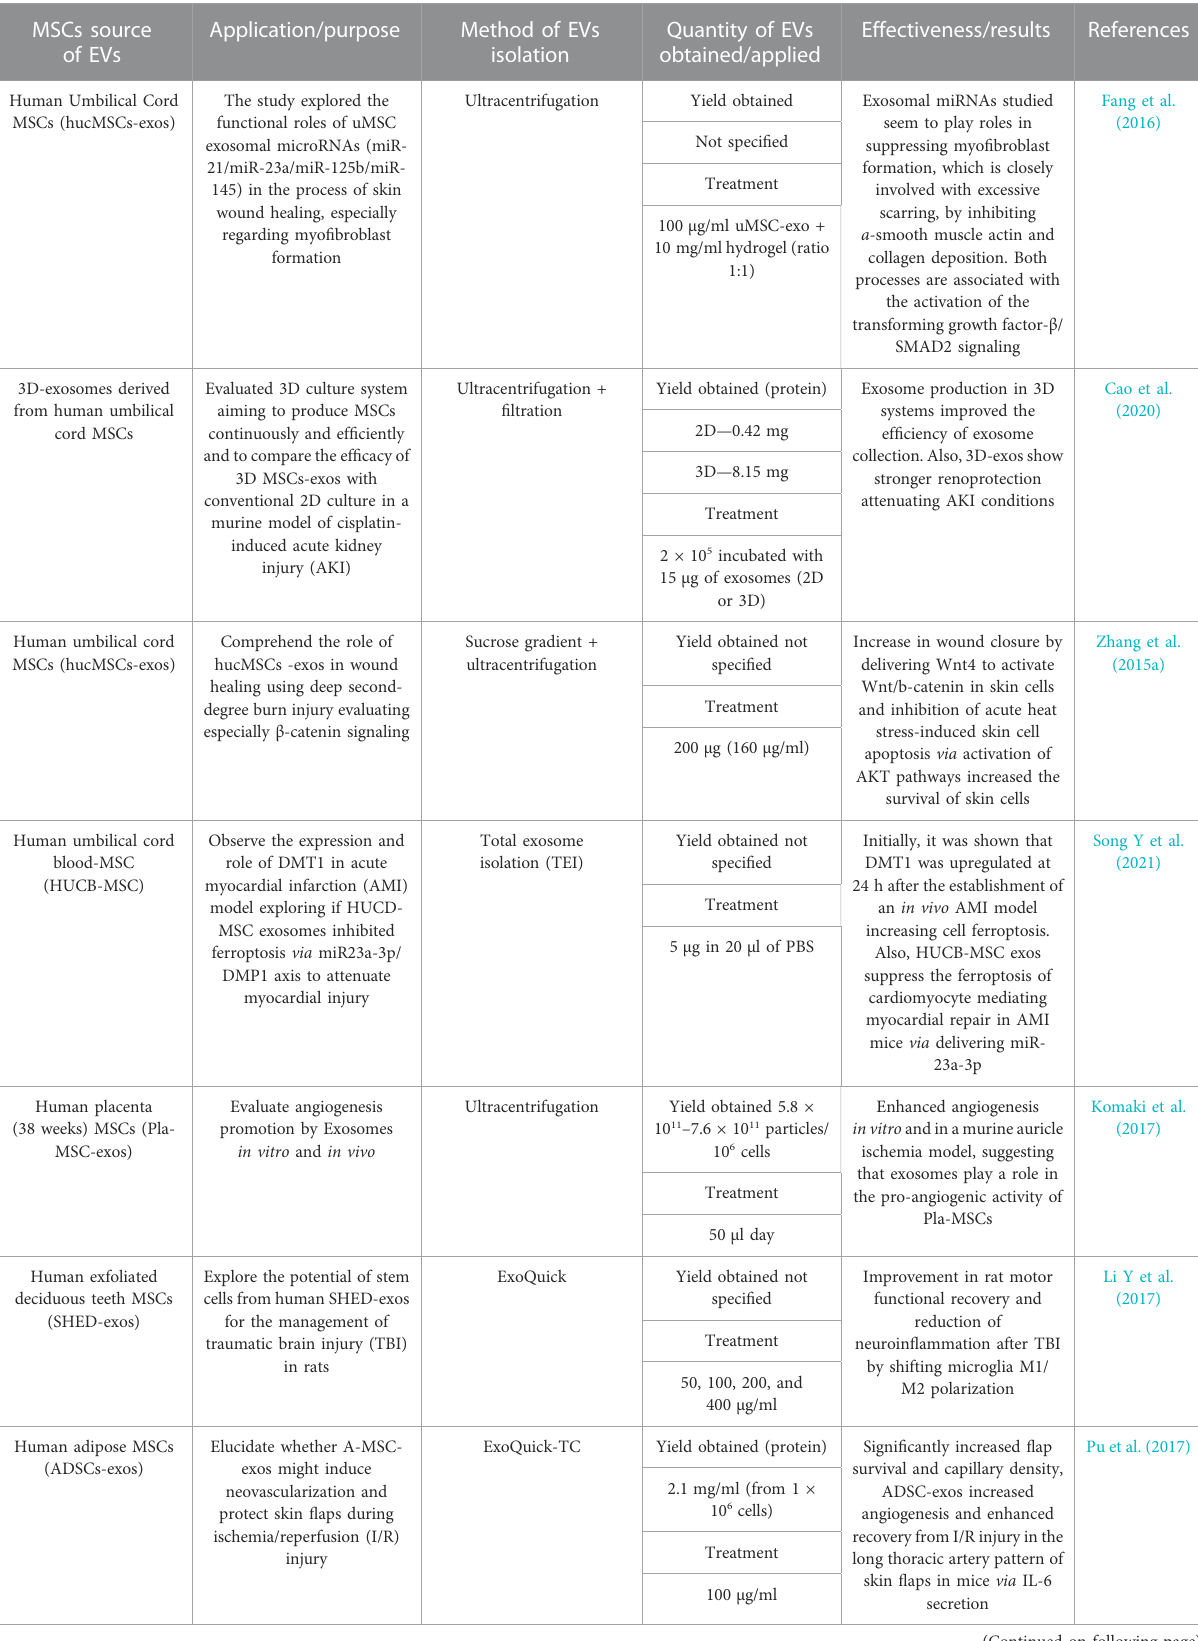
TABLE 2 Different kinds of MSCs used to isolate sEVs with different applications with details of the sEV isolation method and results of each